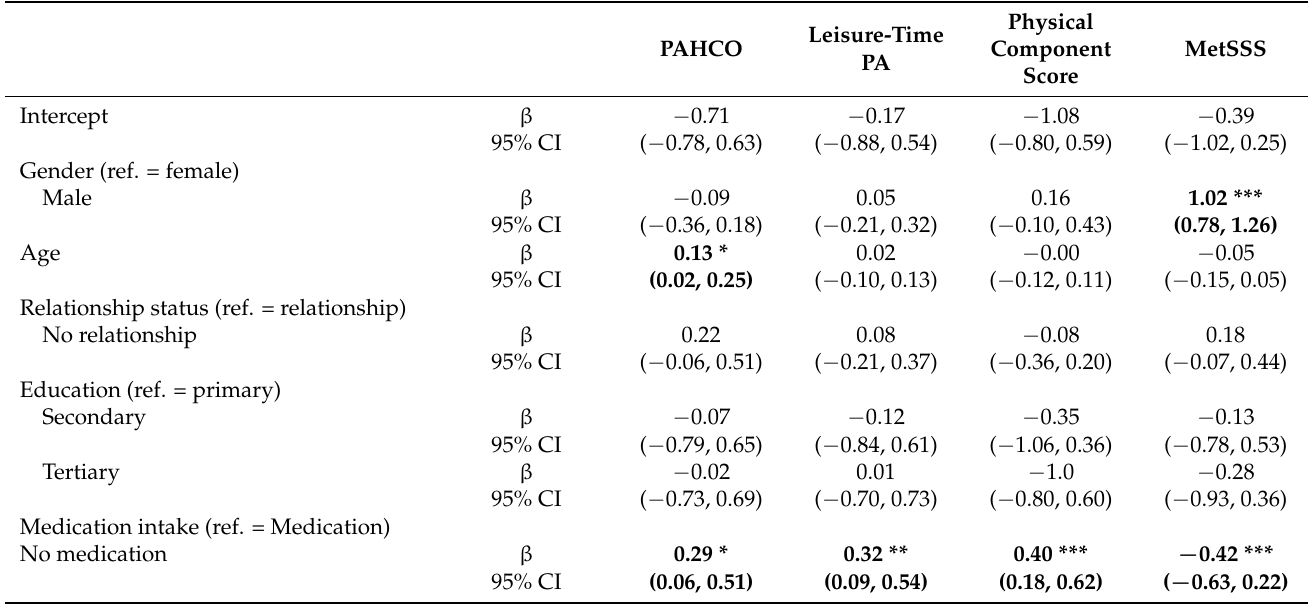
Table A1. Standardized coefficients and 95% CIs of the sociodemographic predictor variables PAHCO, leisure-time PA, Physical Component Score, and